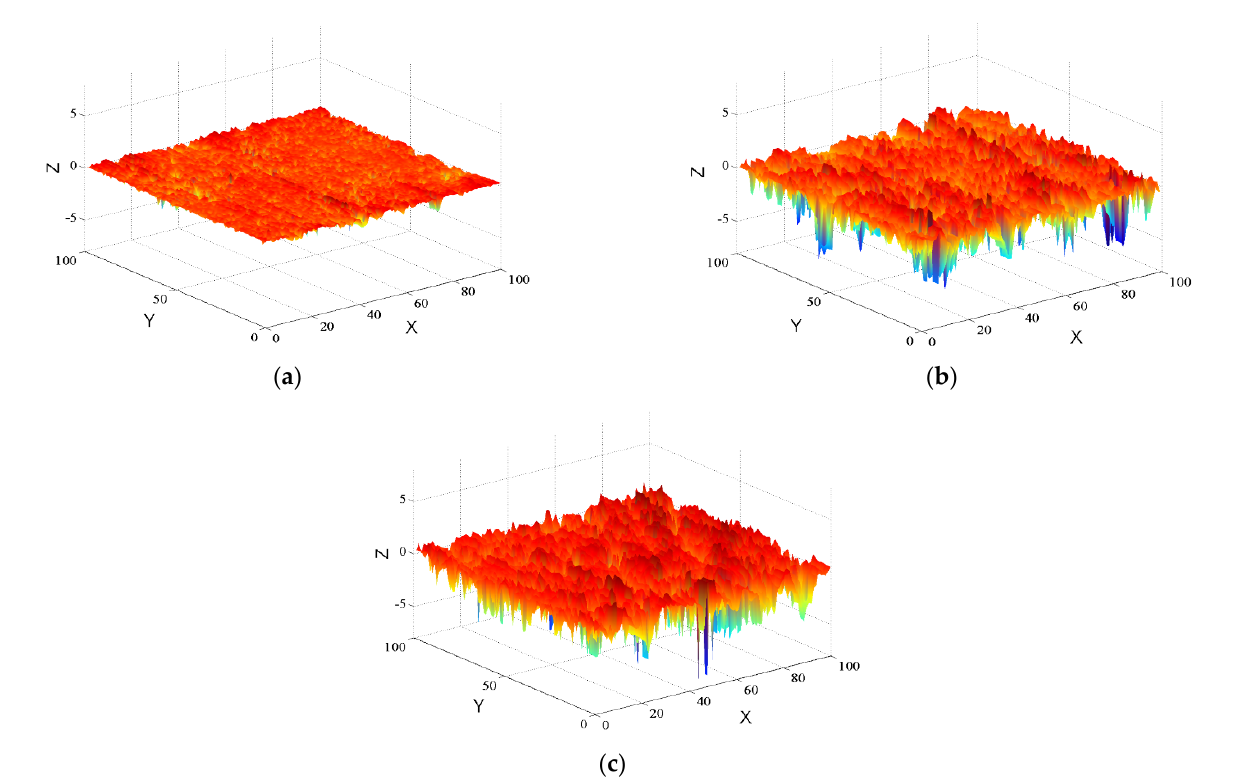
Figure 4. Three—dimensional profile maps of different types of asphalt pavement (Unit: mm). ( a ) AC pavement; ( b ) SMA pavement; ( c ) OGFC pavement.